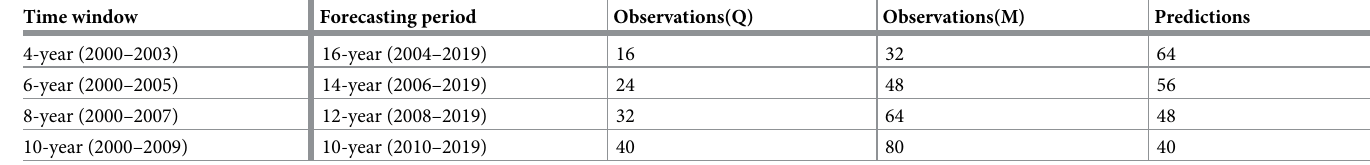
Table 10. The number of observations and predictions of GDP fluctuation states within 4-year, 6-year, 8-year and 10-year time window. Time window Forecasting period Observations(Q) Observations(M)